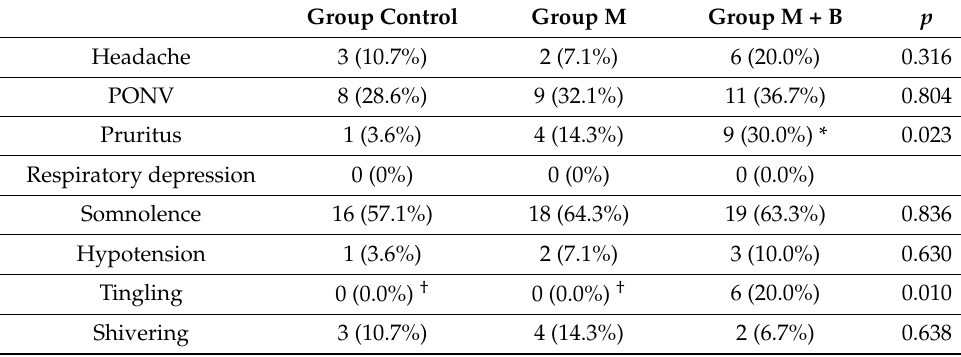
Table 3. Side effects of intrathecal injection for postoperative 3 days.